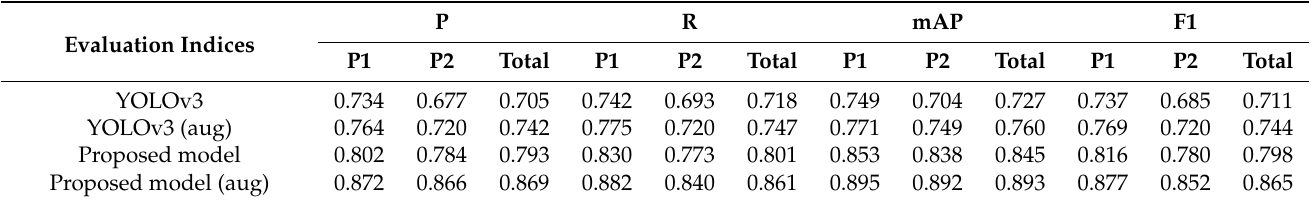
Table 7. Evaluation index results of YOLOv3 model and proposed model before and after data augmentation.